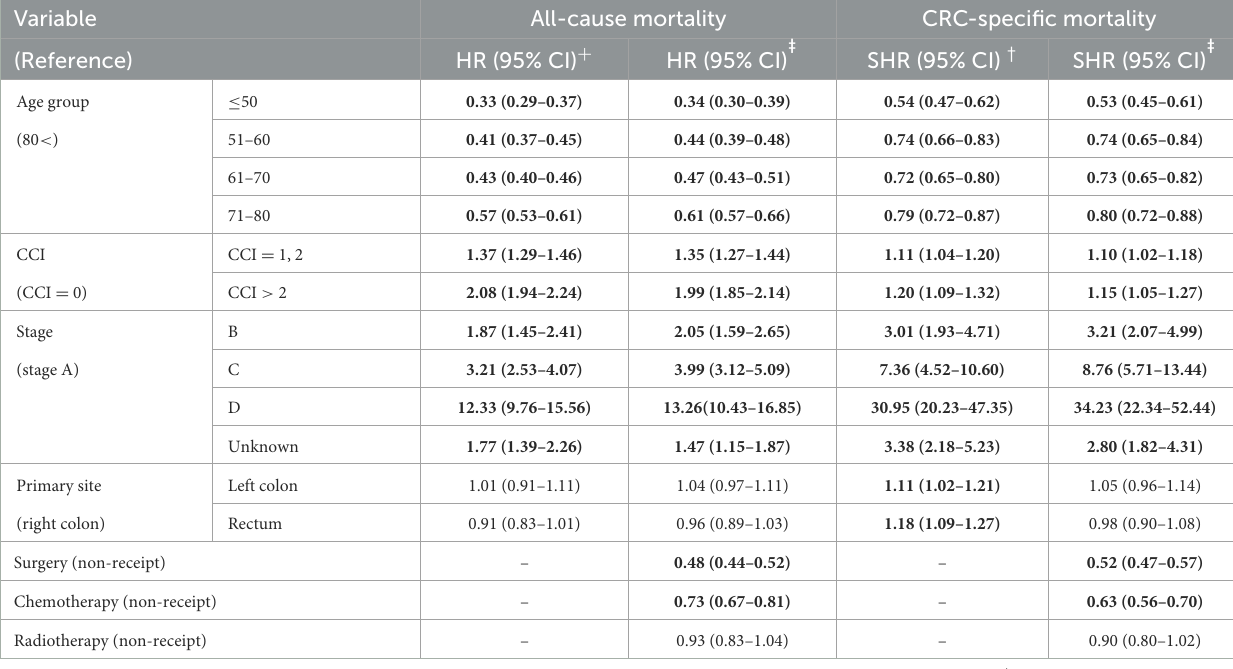
TABLE 3 Associations of age, comorbidity status (CCI), stage (ACPS), grade, primary subsite, and treatment variables with all-cause (HR) and CRC-specific (SHR) mortality (multivariable regression): South Australia, 2004–2013 diagnose, date of censoring December 31, 2014 ∗ . Variable All-cause mortality